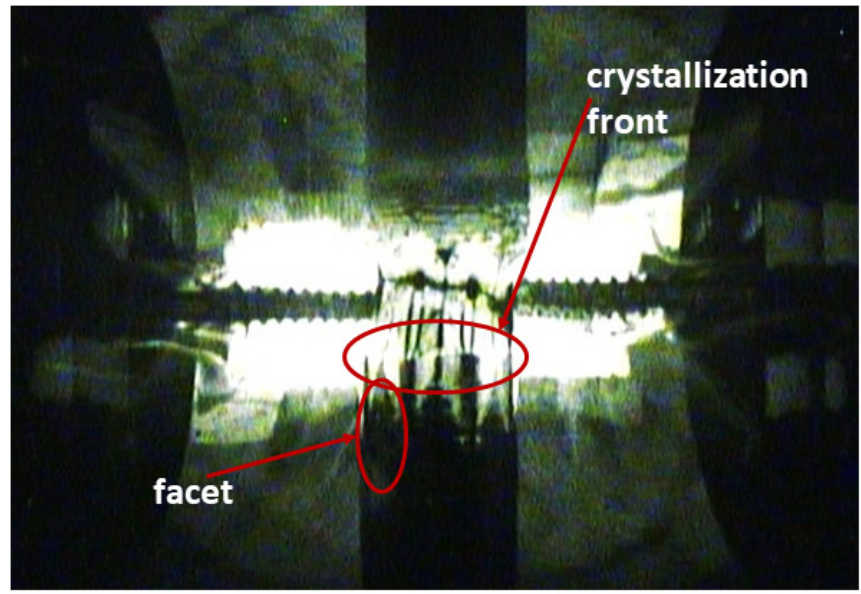
Figure 1. Image of the TSFZ growth of La 1.61 Sr 0.19 Eu 0.2 CuO 4 using a Cu-poor solvent analogous to that used in Ref. [8].